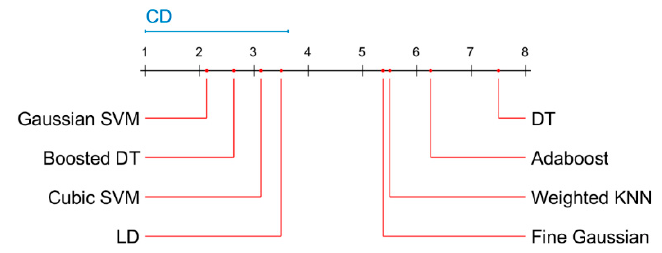
Figure 12. Critical difference diagram of the Nemenyi test results for malware classification using SFTA and features (balanced dataset). CD is critical difference.